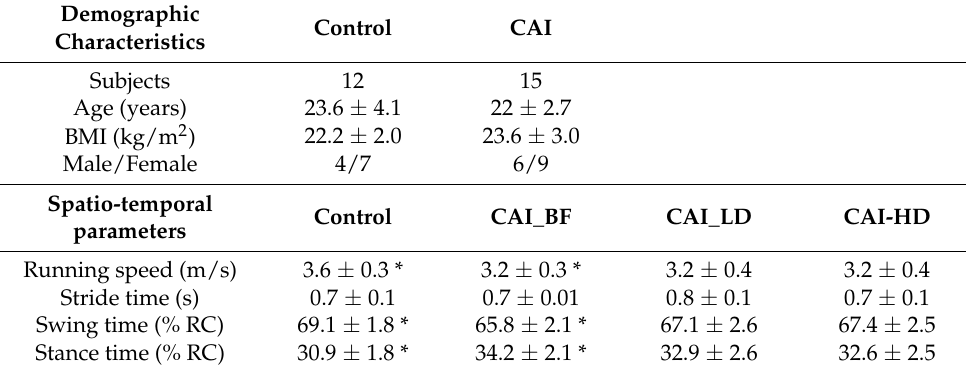
Table 1. Demographic and spatio-temporal data of both groups.